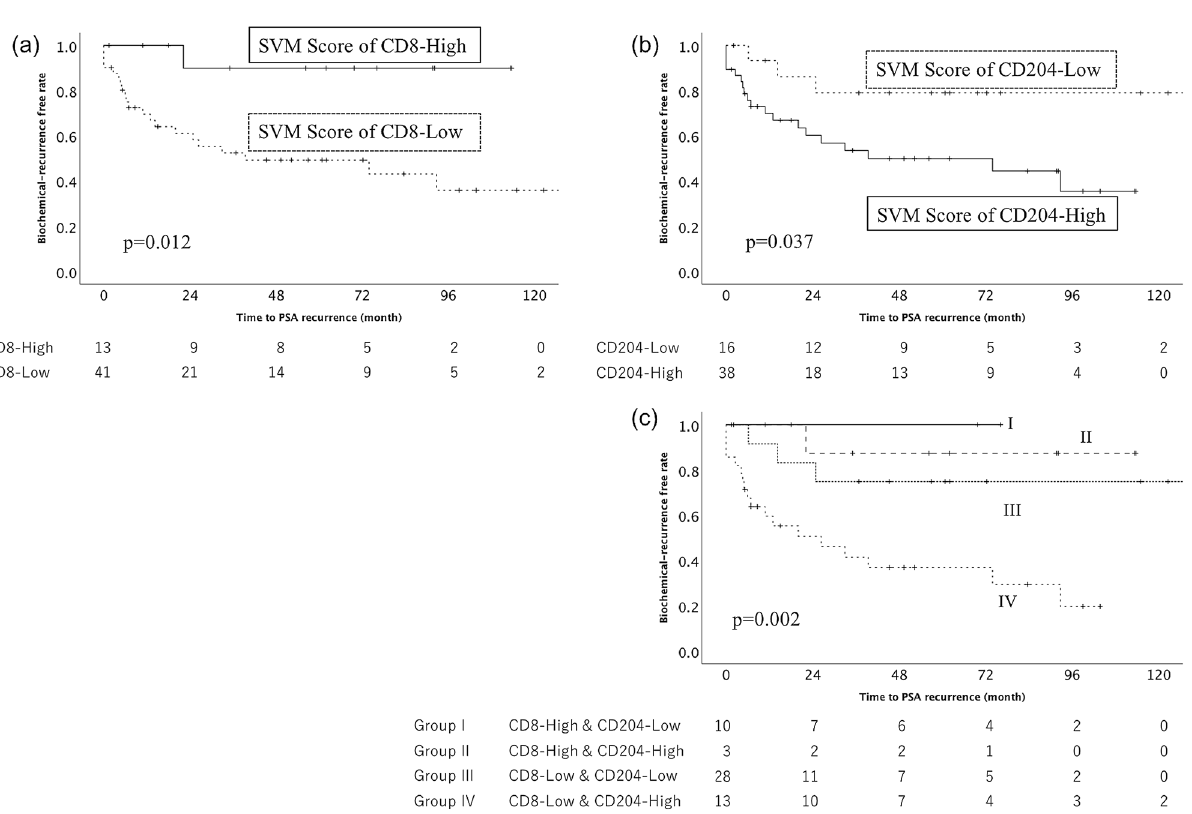
Figure 3. The Kaplan–Meier analysis of the recurrence-free survival of patients with seminal vesicle invasion according to the ratio of the CD8 + and CD204 + cells in the seminal vesicle invasion area to those in the main tumor area ( SVM Score ) for each tumor. A significant difference between the higher and lower SVM Score of CD8 + and CD204 + cell count was observed (CD8: p = 0.012, 4a, CD204: p = 0.037, 4b). Group I, which included patients with the higher SVM Score of CD8 + cell count and the lower SVM Score of CD204 + cell count, had the significantly favorable outcome (p = 0.002,